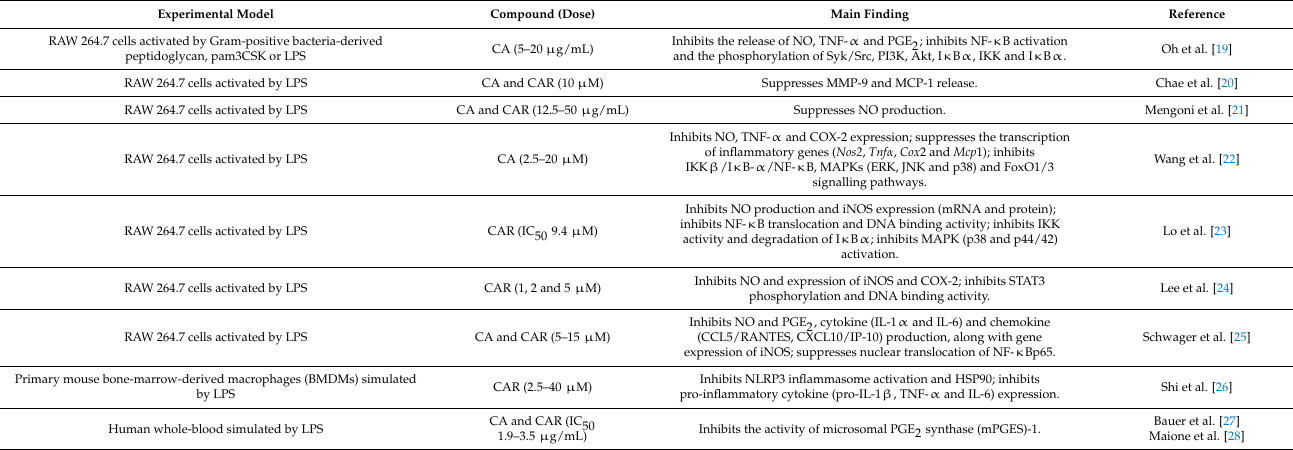
Table 1. Overview of anti-inflammatory mechanisms of CA and CA based on in vitro